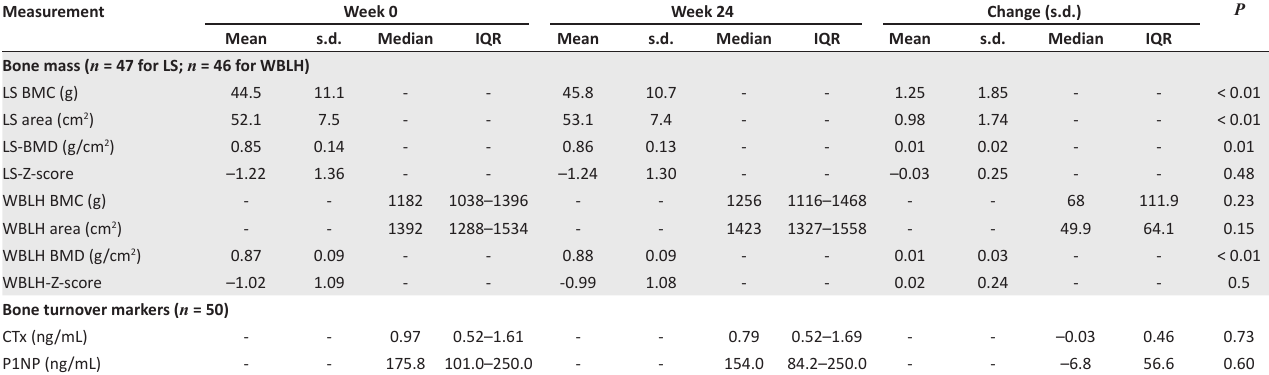
TABLE 2: Bone parameters at Week 0 and Week 24. Measurement